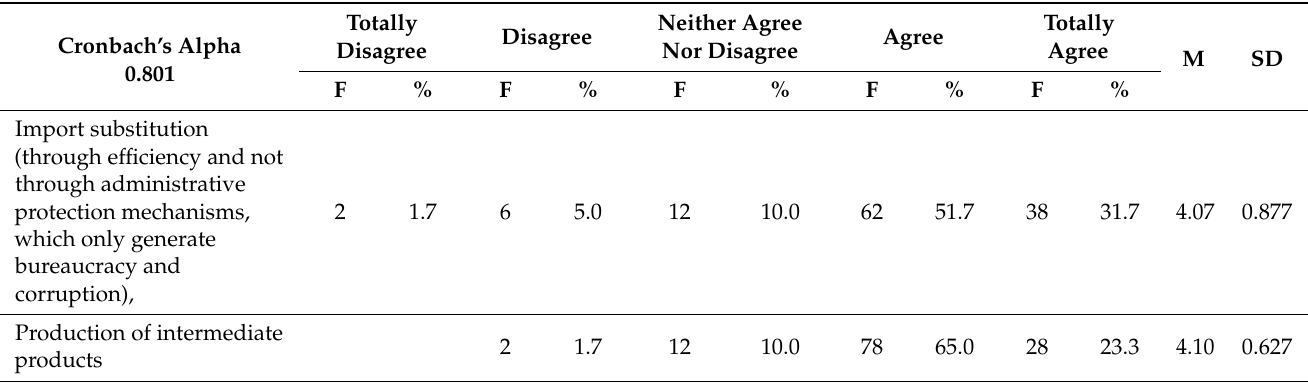
Table 11. Strategic alternatives for diversifying the